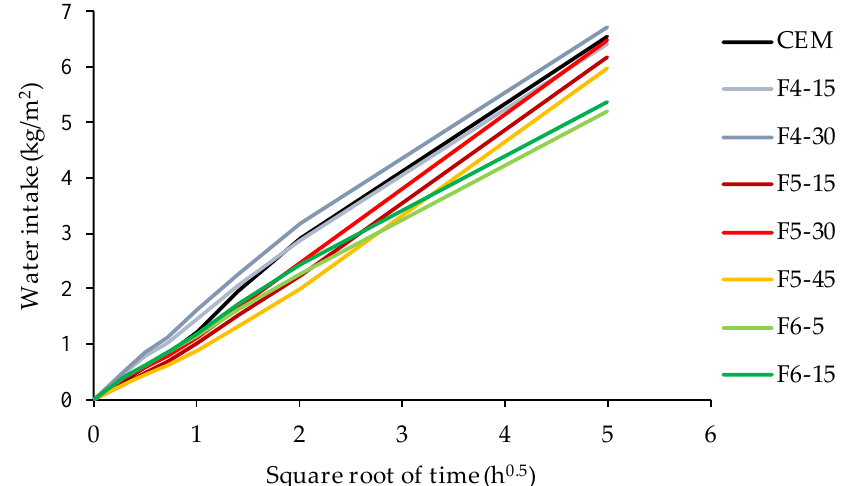
Figure 9. Results of capillary water absorption measurement .